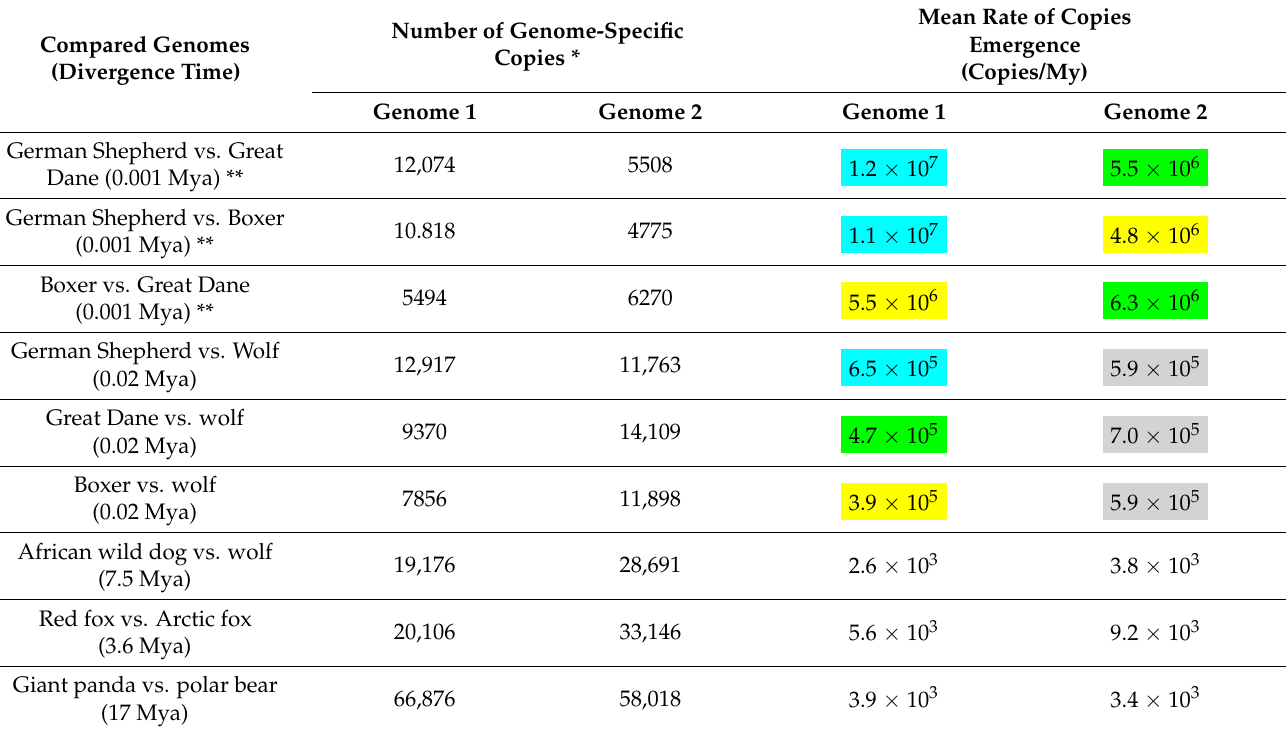
Figure 3. The evolutionary relationships and divergence times of the African wild dog ( Lycaon pictus ), grey wolf ( Canis lupus ) and modern dog breeds. Time is shown on a logarithmic scale. See the text and Table 2 for other explanations and references. Table 2. Number of genome-specific Can copies and rates of their emergence in certain dog breeds, wolf, and other